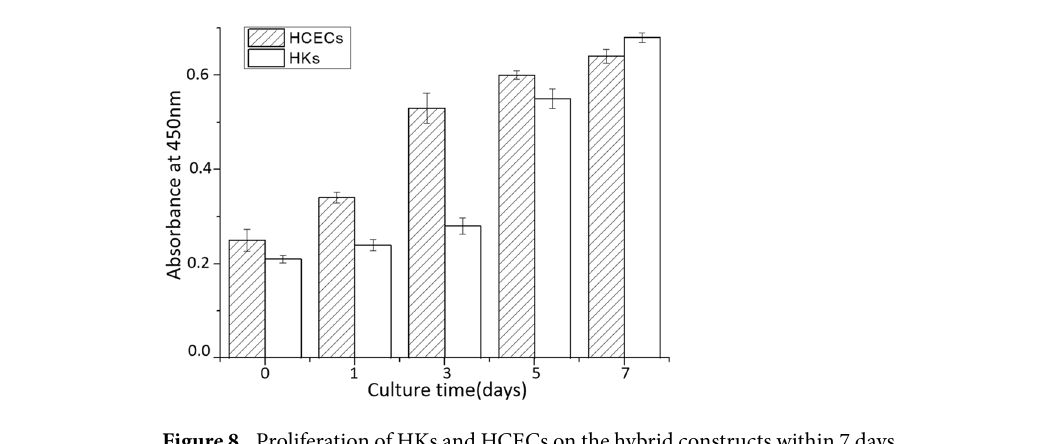
Figure 8. Proliferation of HKs and HCECs on the hybrid constructs within 7